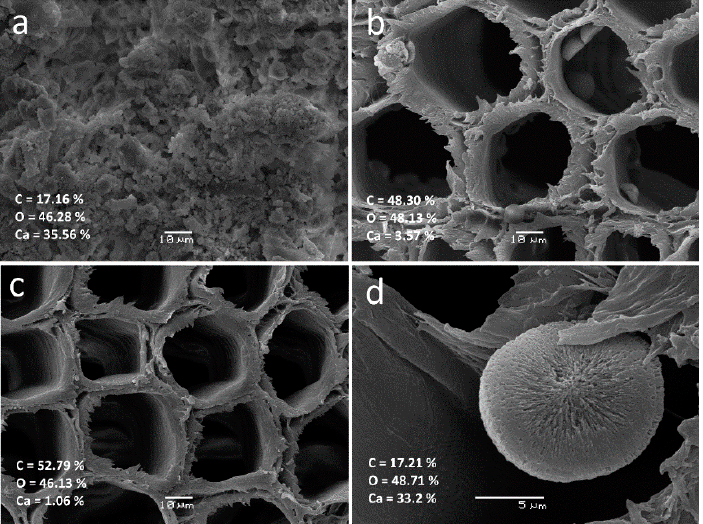
Figure 3. SEM images of a sample treated with 30% calcium chloride, five cycles. ( a ) Surface of the sample; EDS chemical determination: C = 17.16%, O = 46.28%, and Ca = 36.56%, bar size 10 μ m; ( b ) 5 mm depth from the surface of the sample; EDS chemical determination: C = 48.30%, O = 48.13%, and Ca = 3.57%, bar size 10 μ m; ( c ) 10 mm depth from the surface of the sample; EDS chemical determination: C = 52.79%, O = 46.13%, and Ca = 1.06%, bar size 10 μ m; ( d ) semispherical particle formed due to the mineralization process; EDS chemical determination: C = 17.21%, O = 48.71%, and Ca = 33.2%, bar size 5 μ m.